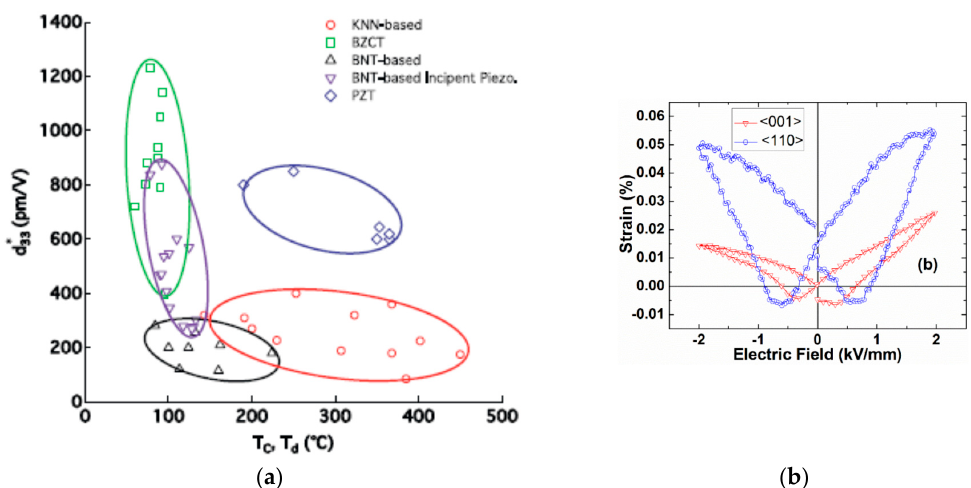
Figure 1. ( a ) A comparison of converse piezoelectric coefficient and maximum usable temperature for different classes of Pb-free and Pb-based piezoelectric ceramics. Reprinted from J. Eur. Ceram. Soc., 35, Rödel et al., “Transferring lead-free piezoelectric ceramics into applications”, 1659–1681, Copyright (2015), with permission from Elsevier. ( b ) Orientation dependent enhancement in electric-field-induced strains in (K,Na)NbO 3 (KNN) single crystal